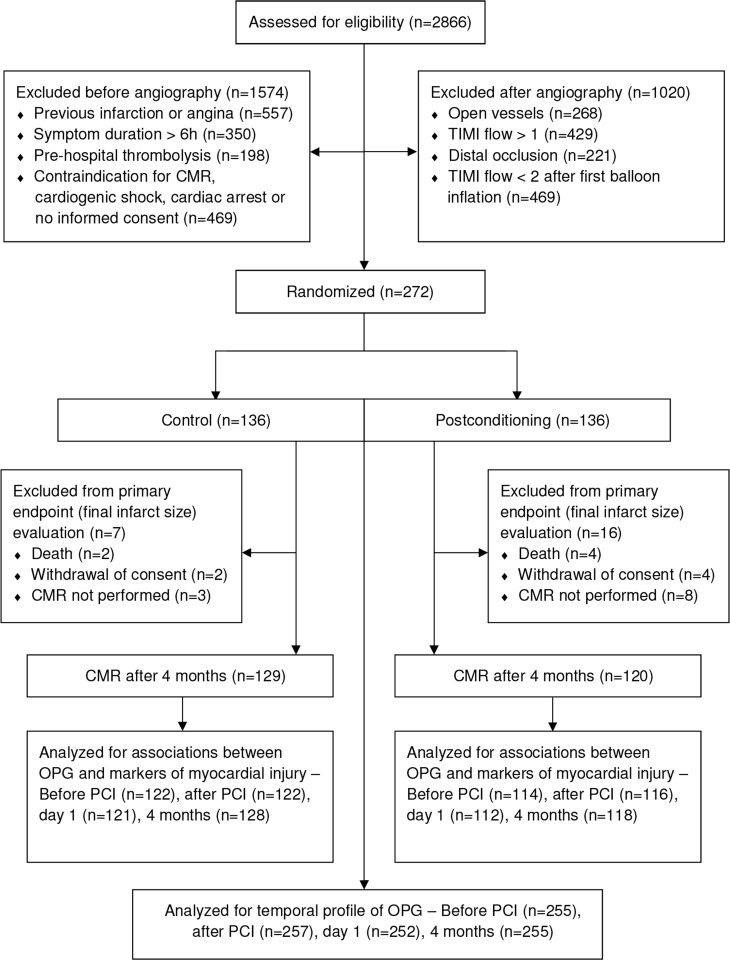
Study flow diagram.